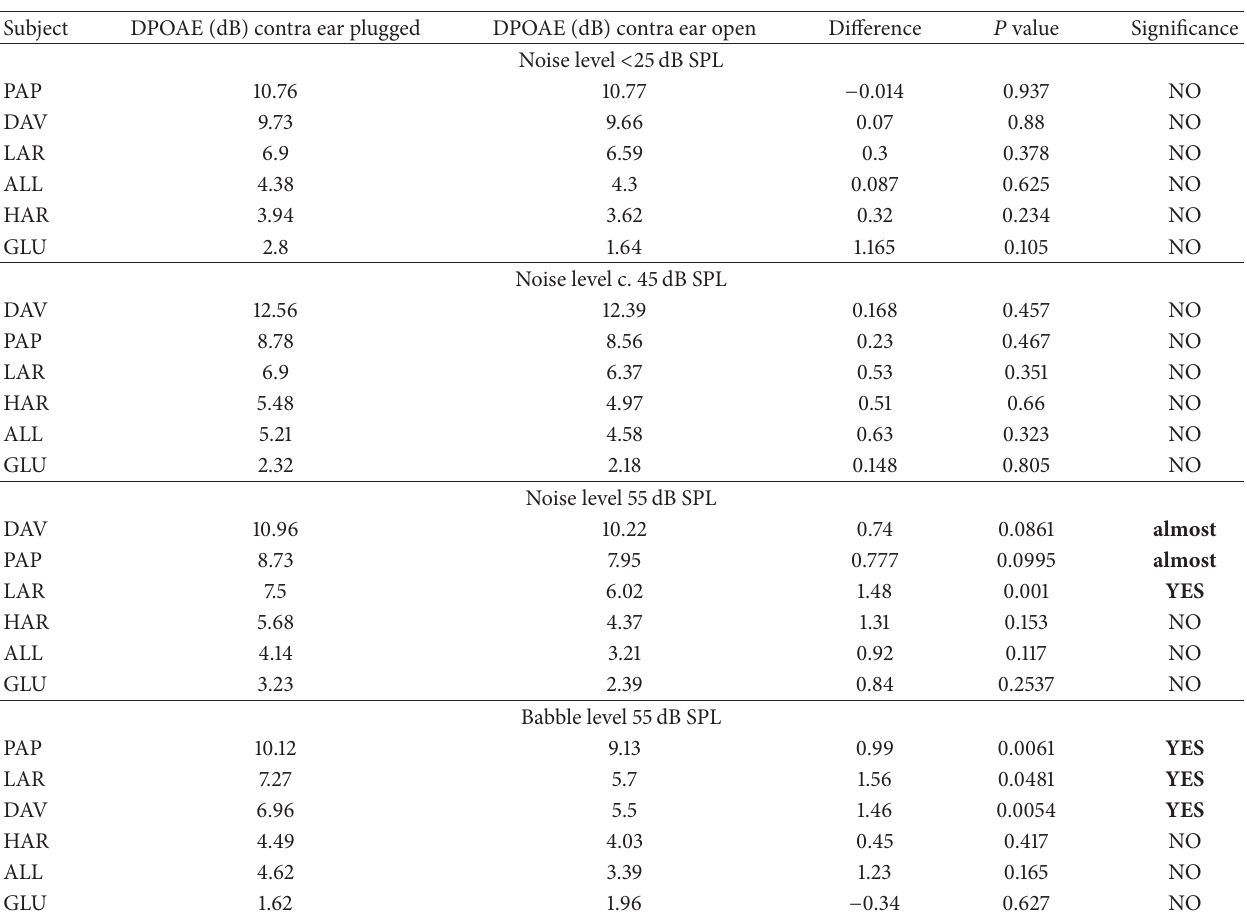
Table 2: DPOAE data from six subjects indicating OAE level recorded with and without occlusion of the contralateral ear in four different ambient sound environments. Results of Student’s 𝑡 -test are